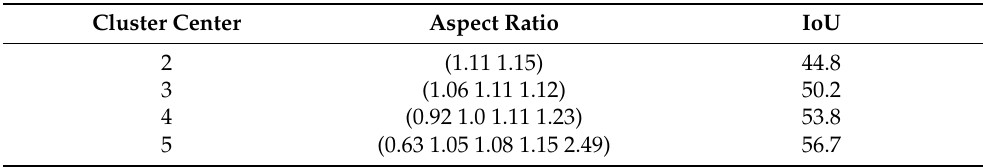
Figure 12. Algorithm flow of k-means clustering anchors. Table 2. Clustering results of